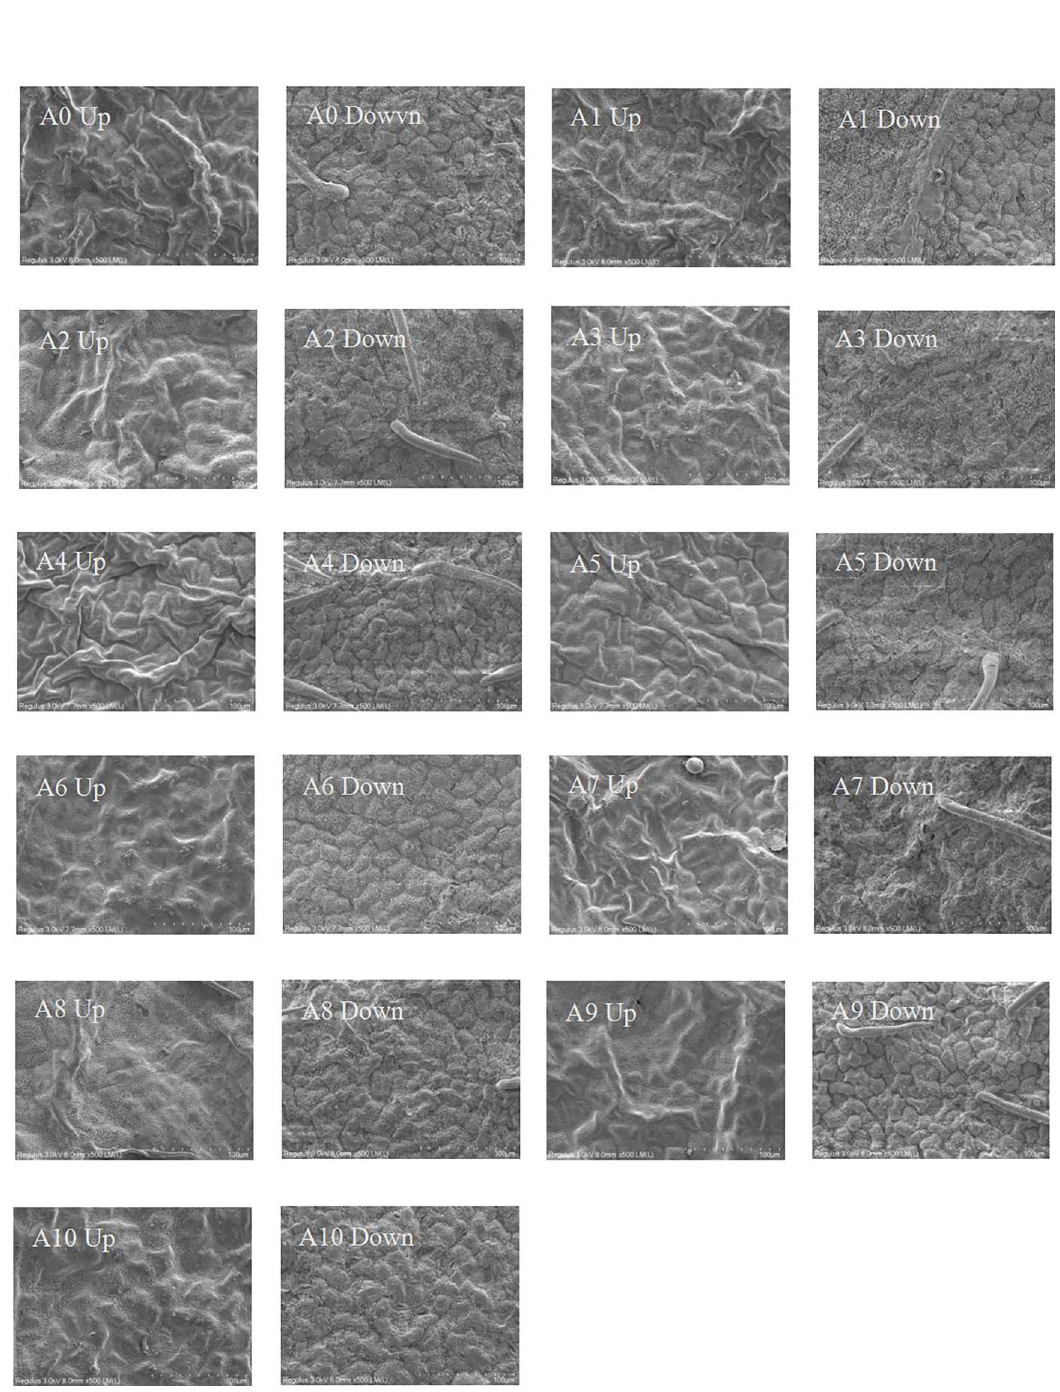
Fig 6. Scanning electron microscopy (SEM) of leaf epidermis micro-configurations in Sophora japonica L. (500 × ). Alphanumeric identifiers indicate the clone number and upper or lower epidermis of the leaf.